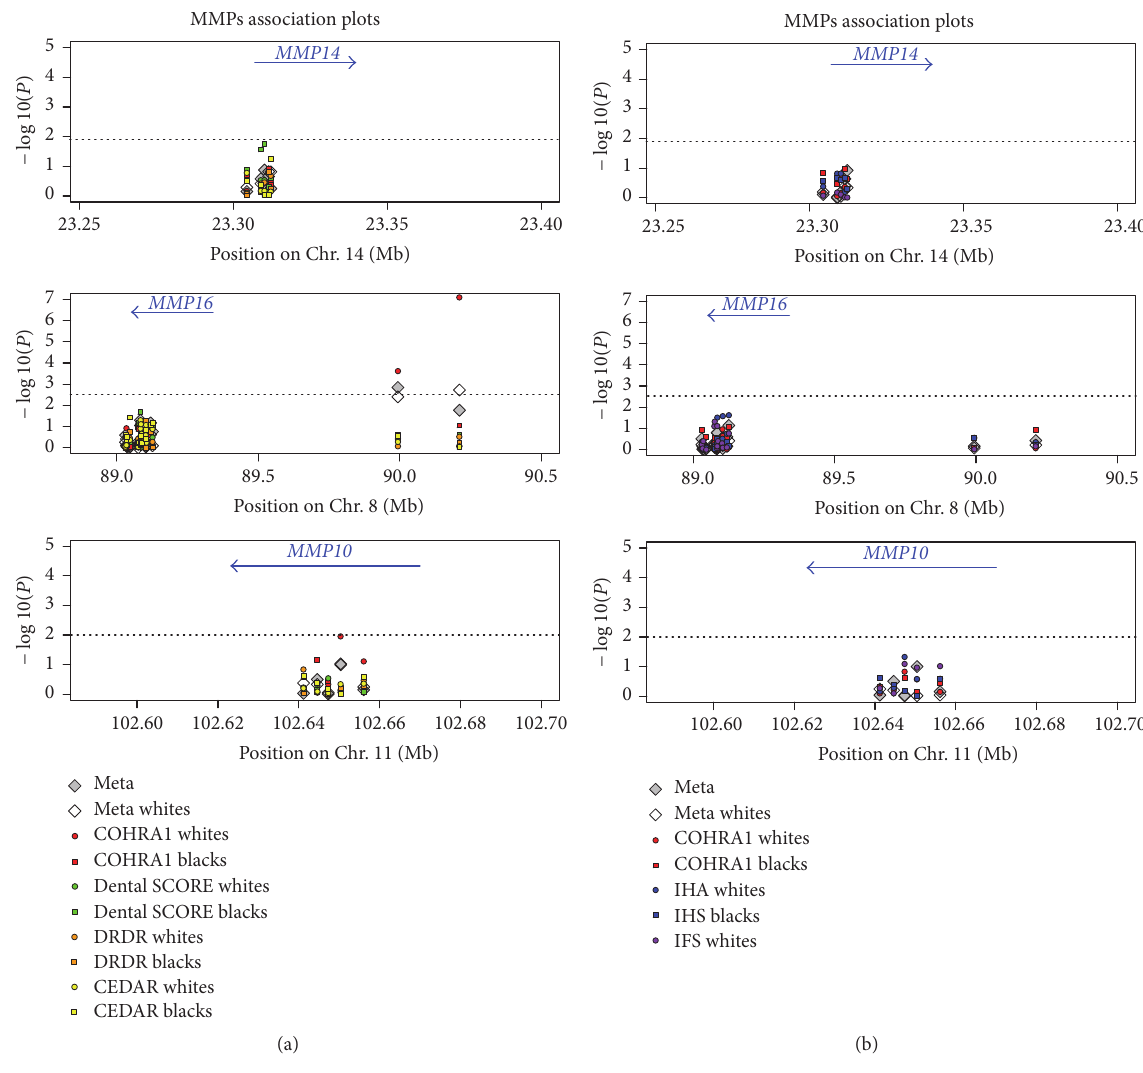
Figure 1: Genetic association in adults and children samples for 3 MMP genes. Genetic association in samples of adults (a) and children (b) for 3 MMP genes. Negative log 10 transformed 𝑝 values are shown. Childhood samples: Center for Oral Health in Appalachia (COHRA1 (red)), Iowa Head Start (IHS (blue)), and Iowa Fluoride Study (IFS (purple)). Adult samples: Center for Oral Health in Appalachia (COHRA1 (red)), Dental Strategies Concentrating on Risk Evaluation (Dental SCORE (green)), Dental Registry and DNA Repository (DRDR (orange)), and Center for Education and Drug Abuse Research (CEDAR (yellow)). Circles represent white samples, and squares represent black samples. For children samples, white diamonds represent meta-analysis across all white childhood samples, and gray diamonds represent meta-analysis across all black and white childhood samples combined. Similarly, for adult samples, white diamonds represent meta-analysis across all white adult samples and gray diamonds represent meta-analysis across all black and white adult samples, combined. The dotted lines represent the 𝑝 threshold after adjustment for the number of independent single nucleotide polymorphisms within a gene. The physical location and directions of the genes are denoted by the blue